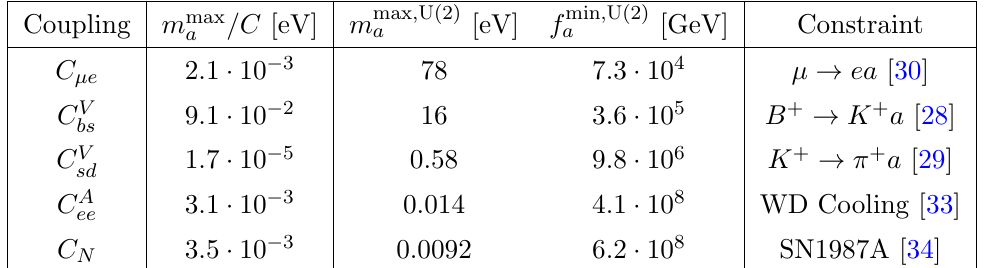
Table 13 . Bounds on selected axion-fermion couplings; here C (cid:22)e (cid:17) q C 2 + C 2 denotes the e(cid:11)ective couplings to nucleons, with axion couplings to protons and neutrons p n C p;n de(cid:12)ned analogously to the axial vector couplings in eq. (4.12). The second column denotes the model-independent upper bounds on the ratio of m a =C , where C denotes the respective coupling, while the third and fourth columns contain the upper (lower) bound on m a ( f a ) in our model, using the numerical results for the couplings of section 3.2, where for explicitness we took the (cid:12)t QL (cid:23) M -1 (other (cid:12)ts give similar